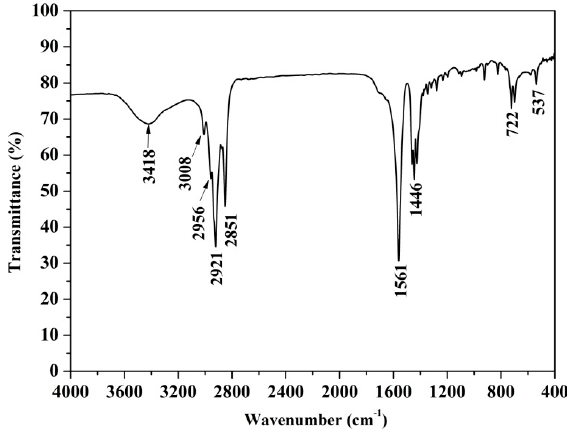
Figure 5. The infrared spectra of sodium oleate.